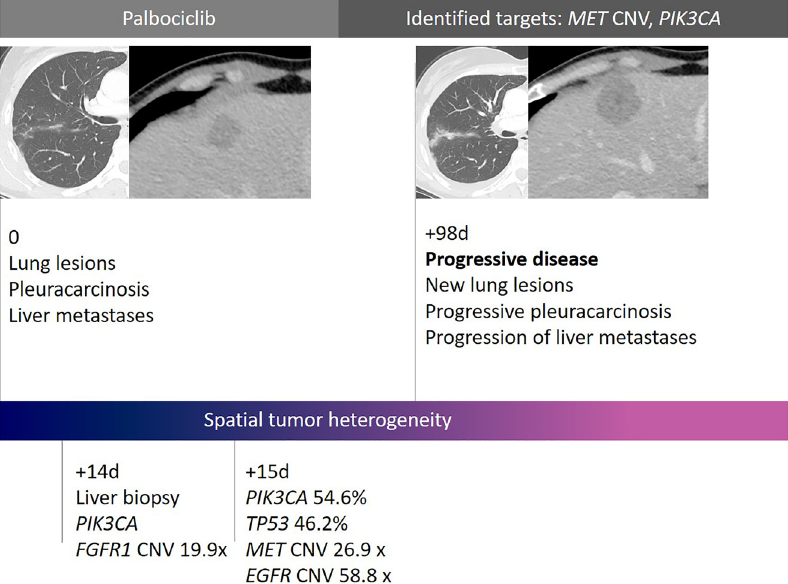
Figure 2: Liquid profiling for identification of molecular druggable